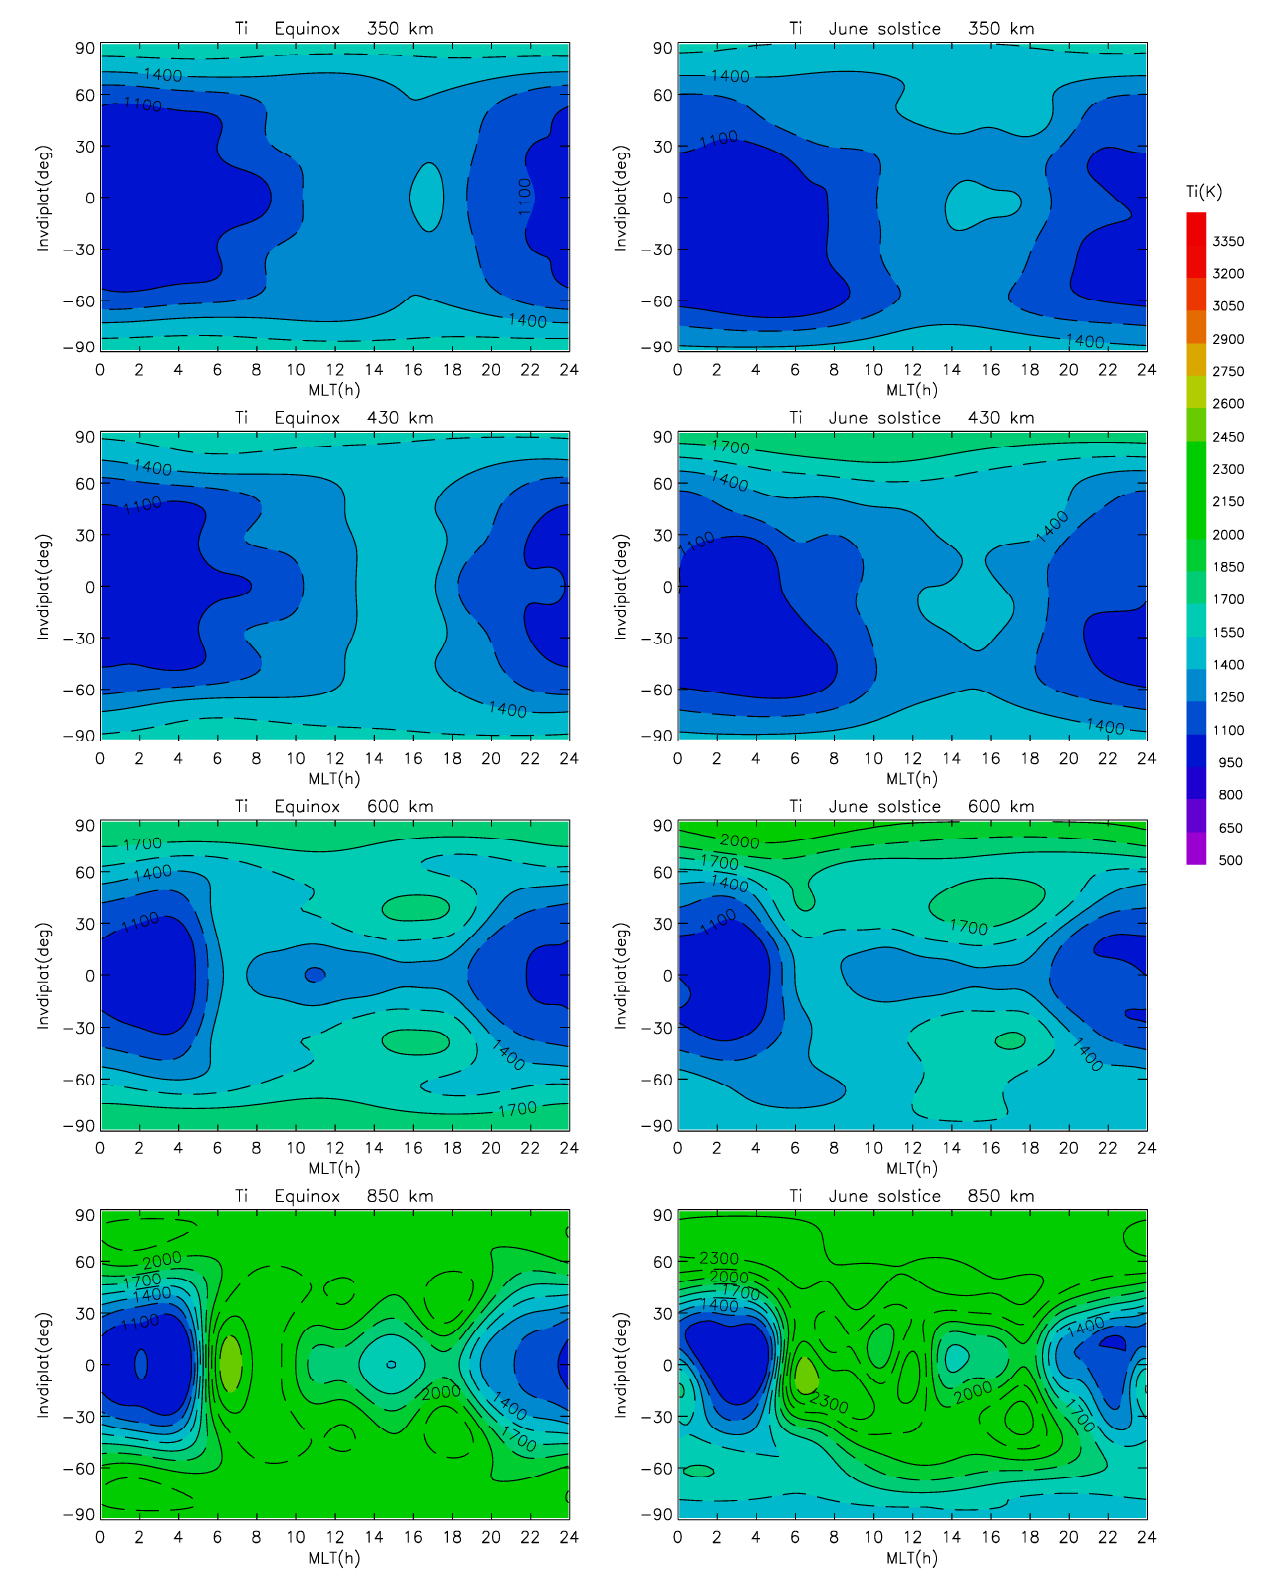
Figure 6. Contour plots of the Ti model for equinox and solstice for four altitude intervals and solar maximum (PF10.7 = 200).